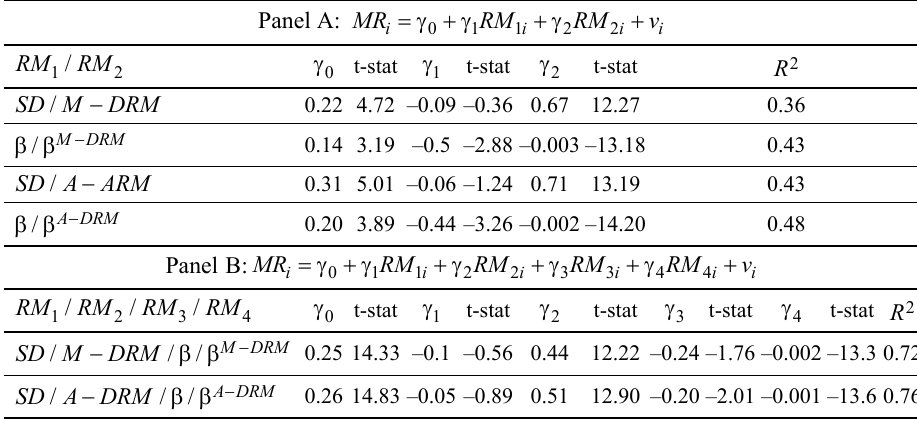
Table 4. Multiple regression analysis upon full